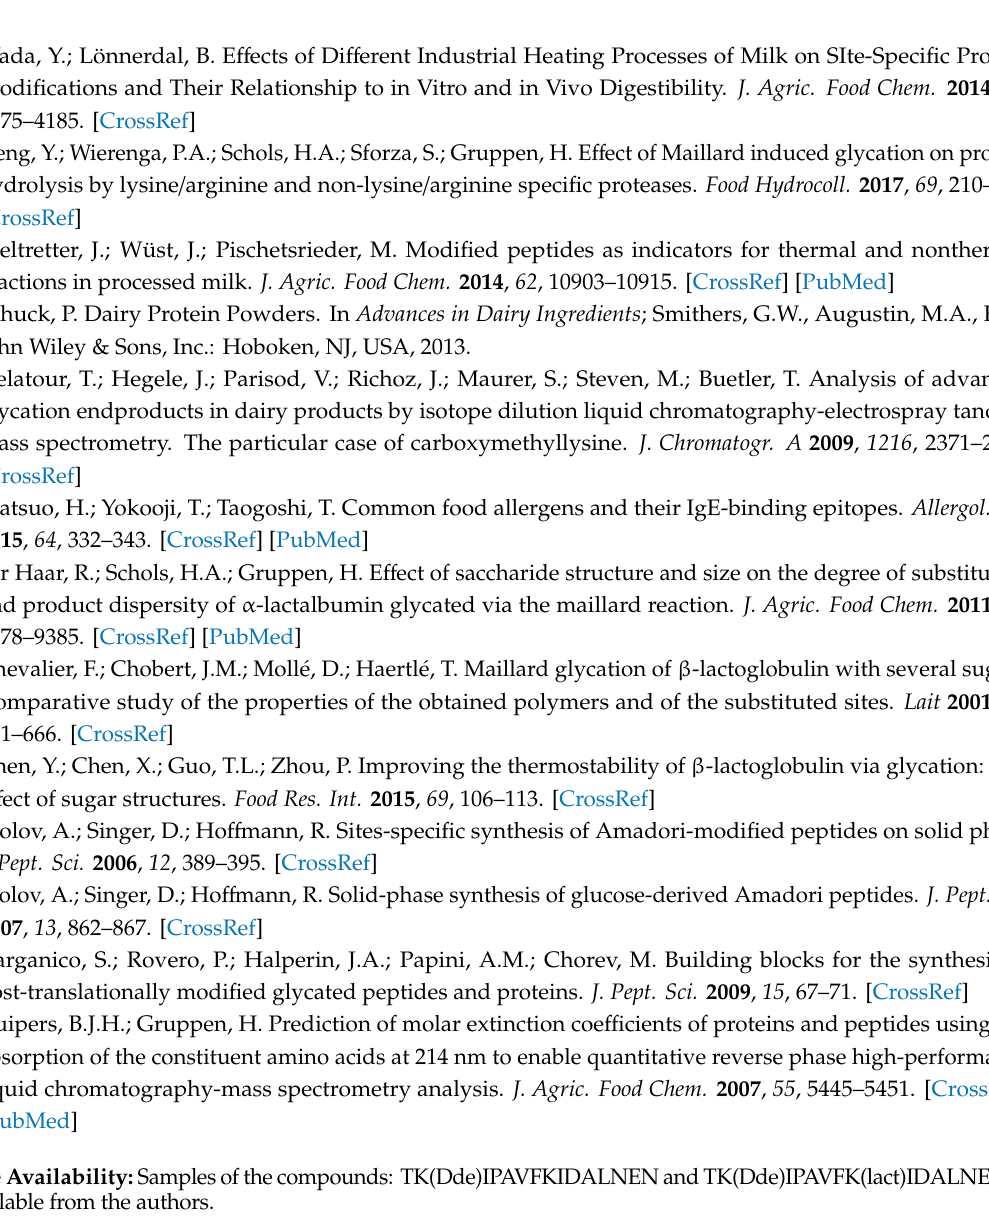
Sample Availability: Samples of the compounds: TK(Dde)IPAVFKIDALNEN and TK(Dde)IPAVFK(lact)IDALNEN..... are available from the